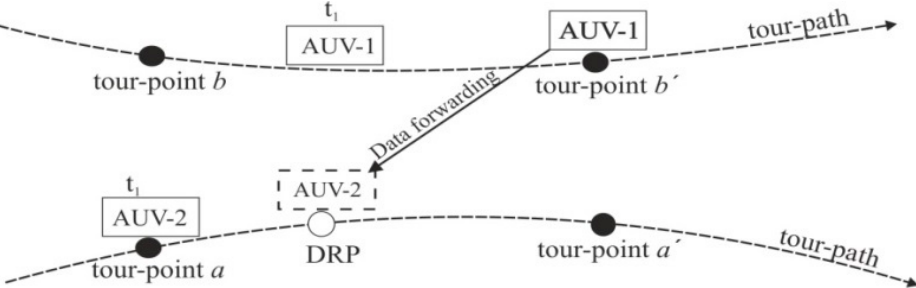
Figure 2. AUV → AUV data-gathering at the DRP.